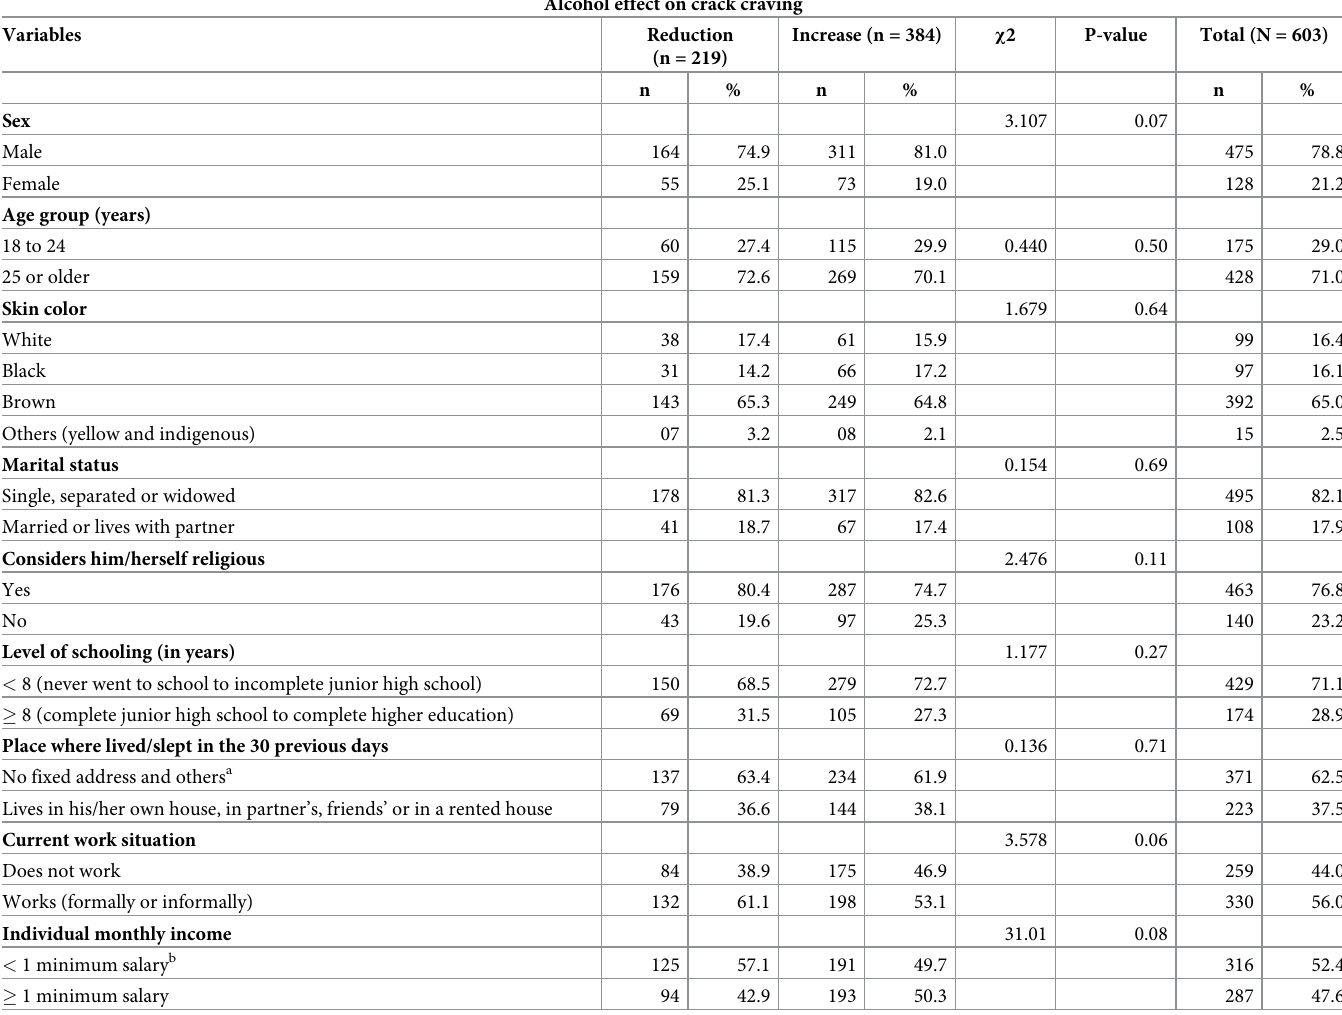
Table 1. Socio-demographic characteristics of people who use crack that reported some effect of alcohol on crack craving, assisted in the Atitude Program, Pernam- buco, August 2014 to August